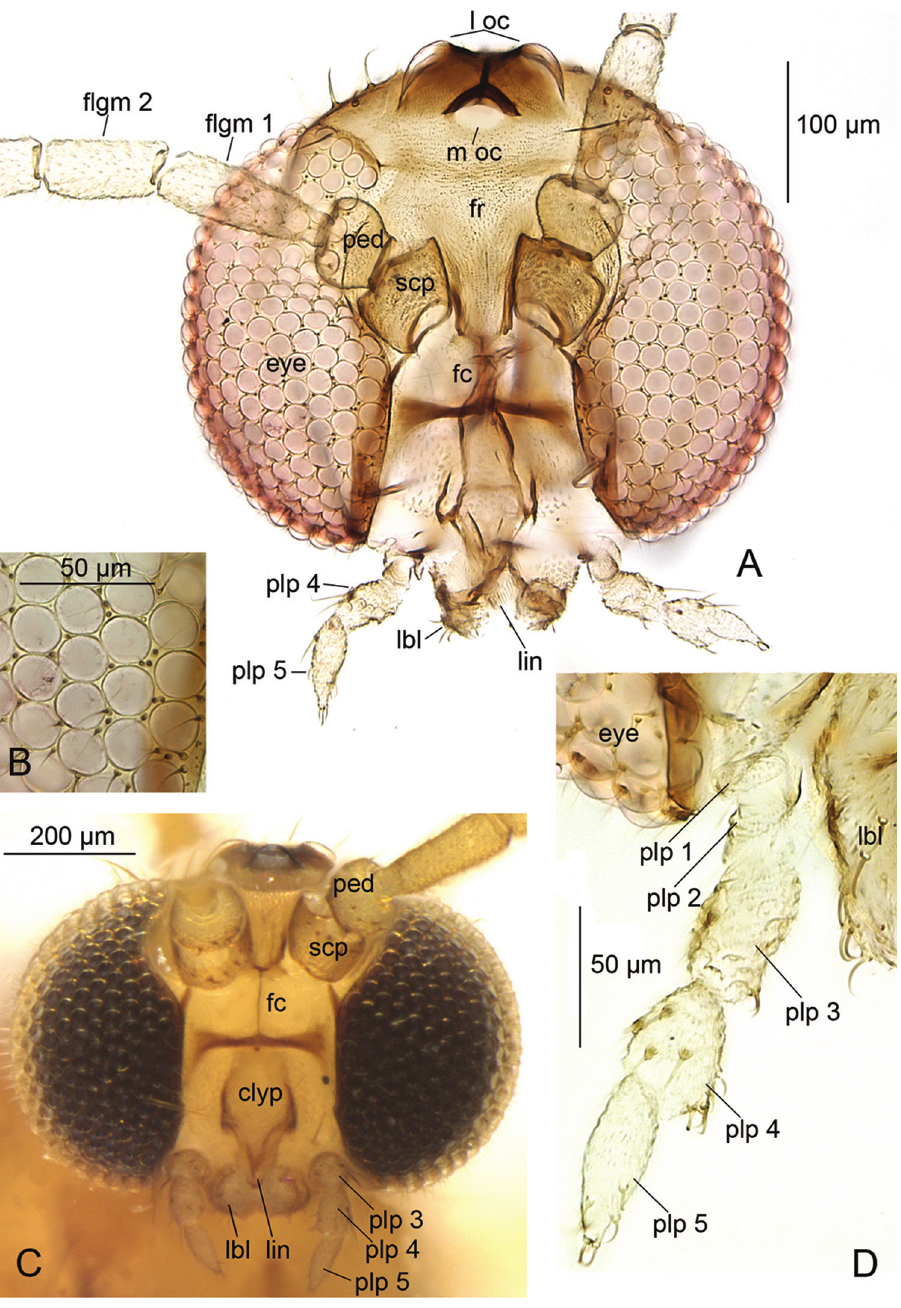
Figure 4. Kibaleana apicospinosa sp. n., male. A Head, frontal view B Compound eye, closer view C Head, frontal view D Maxillary palpus, posterior view. Abbreviations: clyp = clypeus; eye = compound eye; fc = face; flgm = flagellomeres; fr = frons; lbl = labellum; lin = lingua; l oc = lateral ocellus; m oc = medial ocellus; ped = pedicel; plp = segments of maxillary palpus; scp =